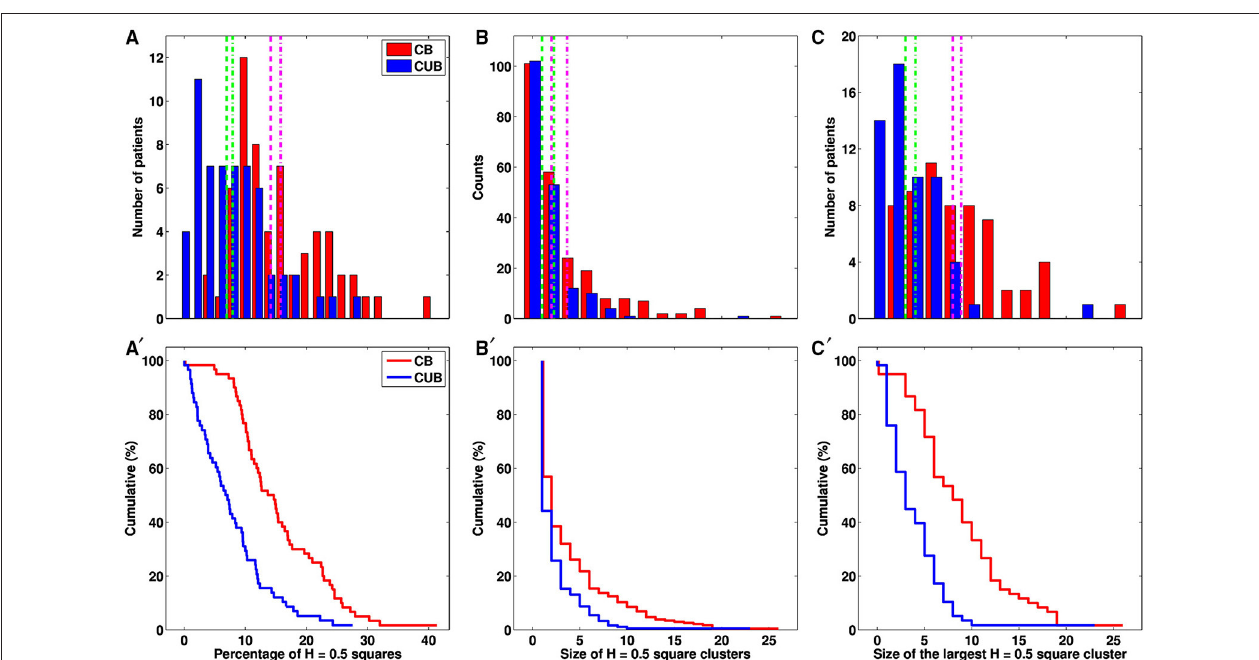
FIGURE 4 | Differential monofractal H = 0.5 signature on the (CC and MLO) mammograms of cancerous breasts (CB) and contralateral unaffected breasts (CUB). (A) Histograms of the percentage of squares in the mammograms of the CBs (red) and CUBs (blue) of 30 patients with breast cancer. (B) Histograms of the size of H = 0.5 square clusters (see text) in CBs (red) and CUBs (blue). (C) Histograms of the size of the largest H = 0.5 square cluster in CBs (red) and CUBs (blue). (A ′ –C ′ ) same as (A–C) for the corresponding cumulative distribution functions. Clusters are defined by squares sharing a common edge or corner. In (A–C) , the pink and green vertical lines correspond to the mean (dashed line) and median (dashed-dotted line) of the histogram obtained for CBs and CUBs respectively.